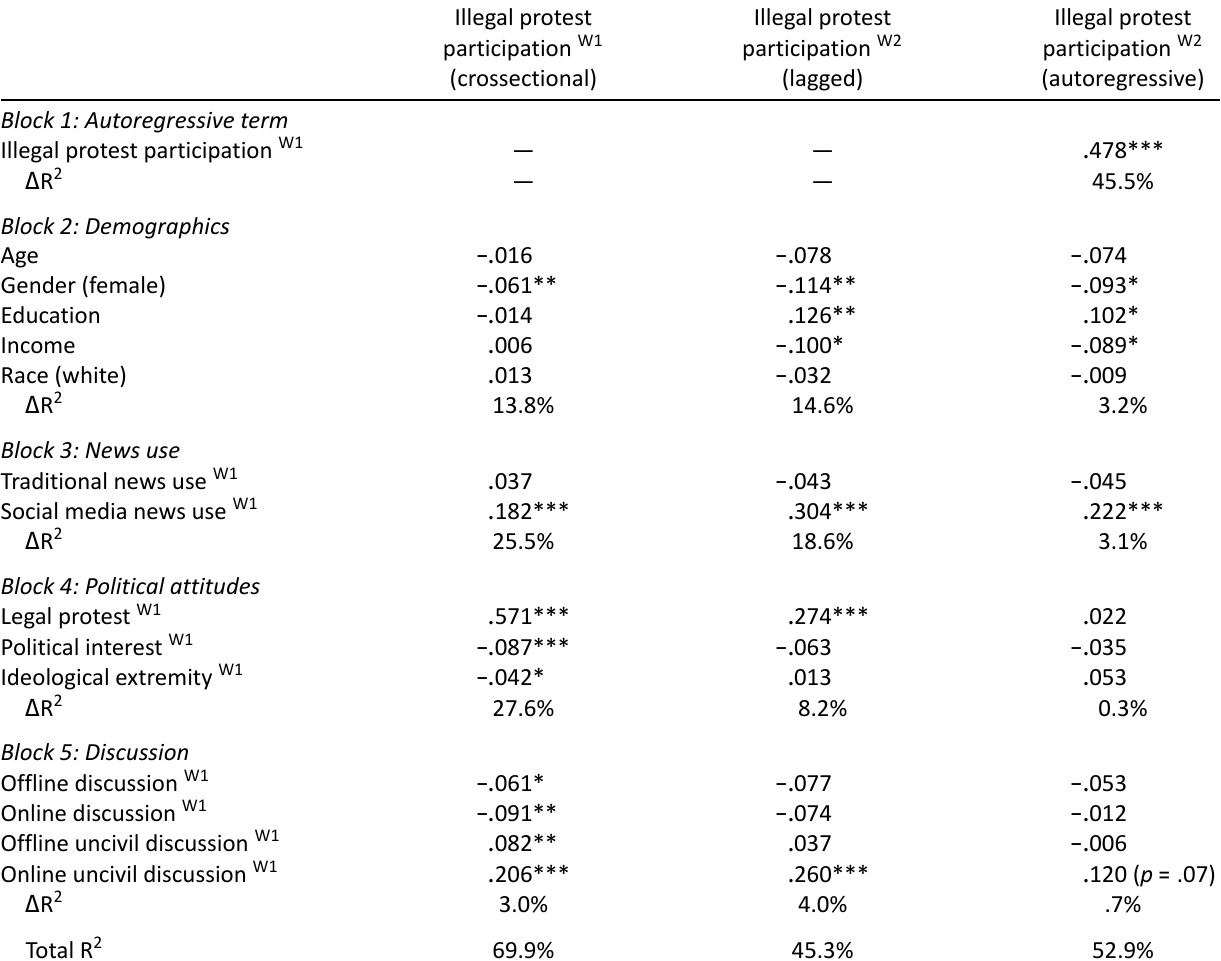
Table 2. Cross‐sectional, lagged, and autoregressive regression models testing uncivil discussion (offline & online) and illegal protest.